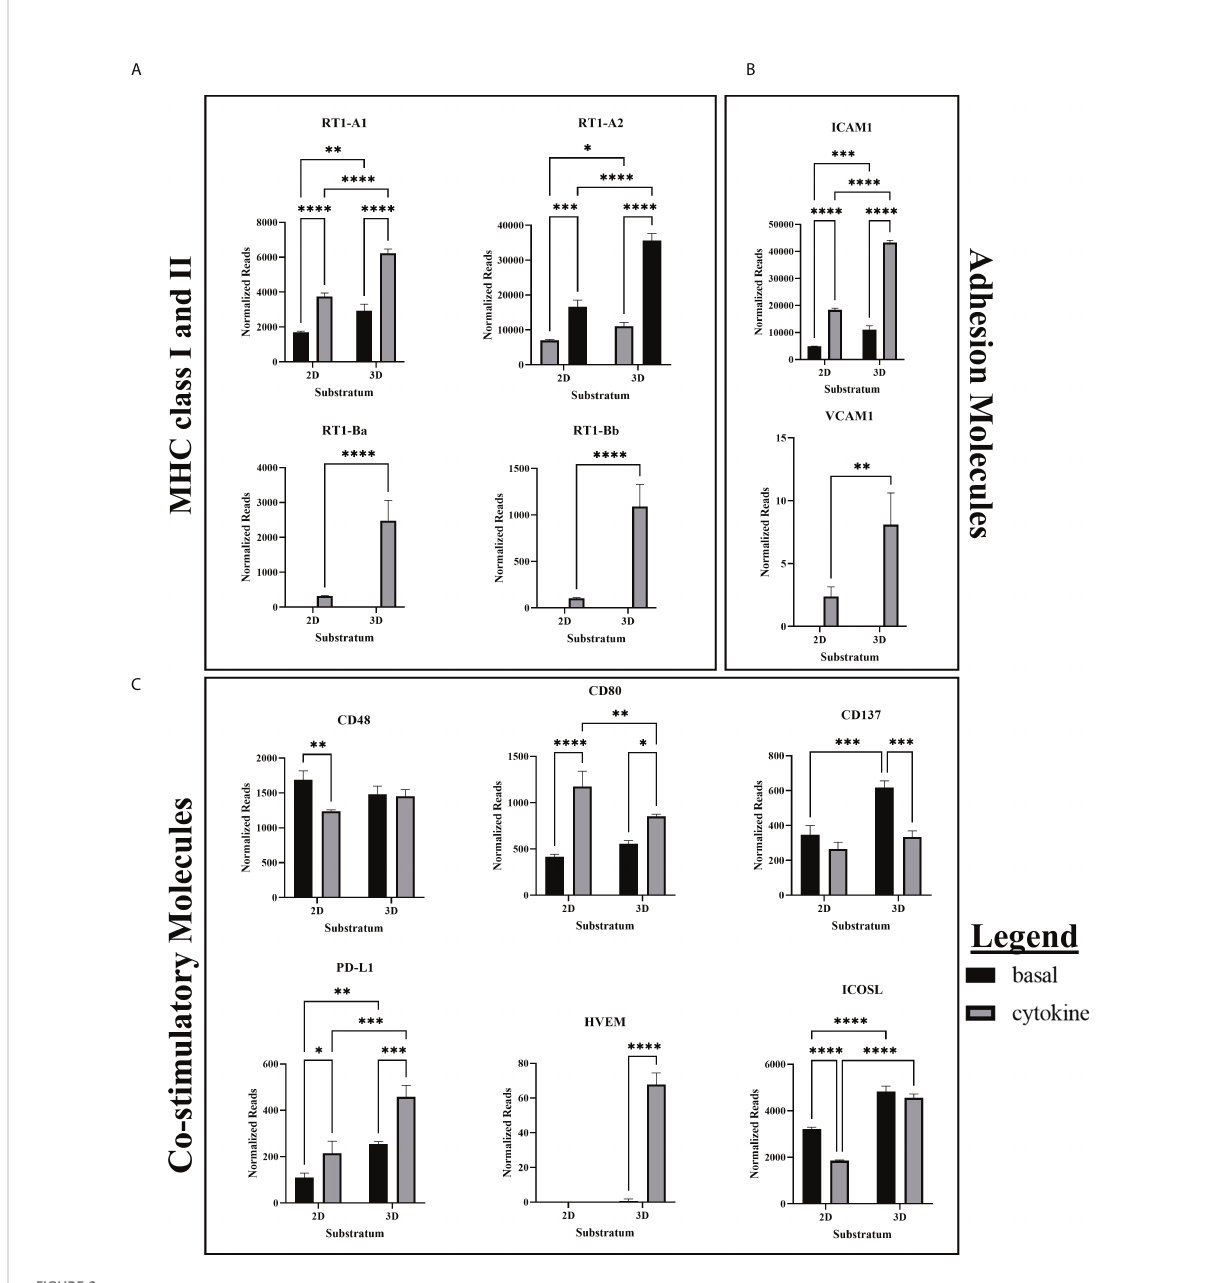
FIGURE 2 RNA expression of MHC, co-stimulatory, and adhesion molecules. (A) RNAseq showed greater basal expression and upregulation of MHC class I and class II in response to cytokine stimulation in 3D ECs. (B) RNA Expression of ICAM1 and VCAM1 is upregulated in cytokine-treated and 3D cultured ECs. (C) CD80 and PD-L1 were constitutively expressed while HVEM was induced by cytokine treatment. Cytokine treatment decreased expression of CD137 in 3D ECs, and CD48 and ICOSL in 2D ECs. RNAseq cytokine ECs were treated with IFN g and TNF a . Statistics: RNA – two-way ANOVA. n = 3. *(P ≤ 0.05), **(P ≤ 0.01), ***(P ≤ 0.001), ****(P ≤